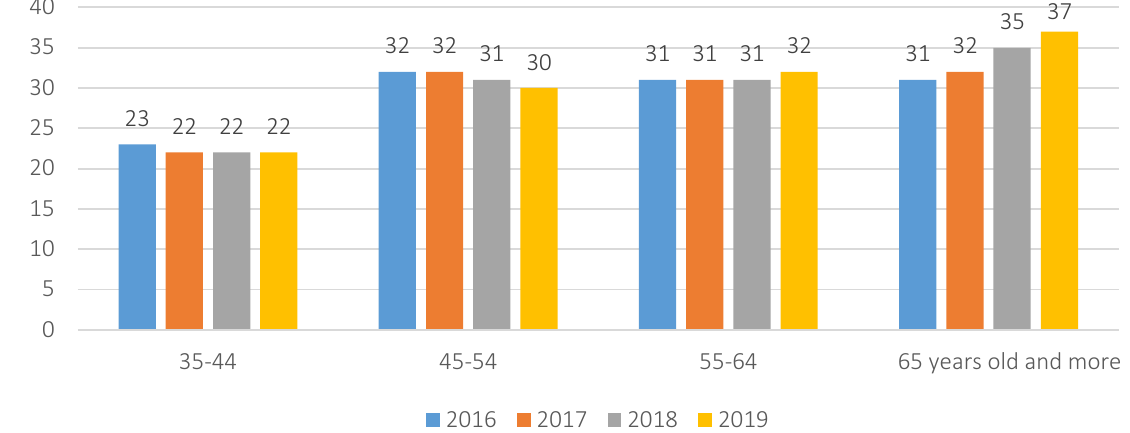
Figure 2. Doctors authorized to perform their profession by age